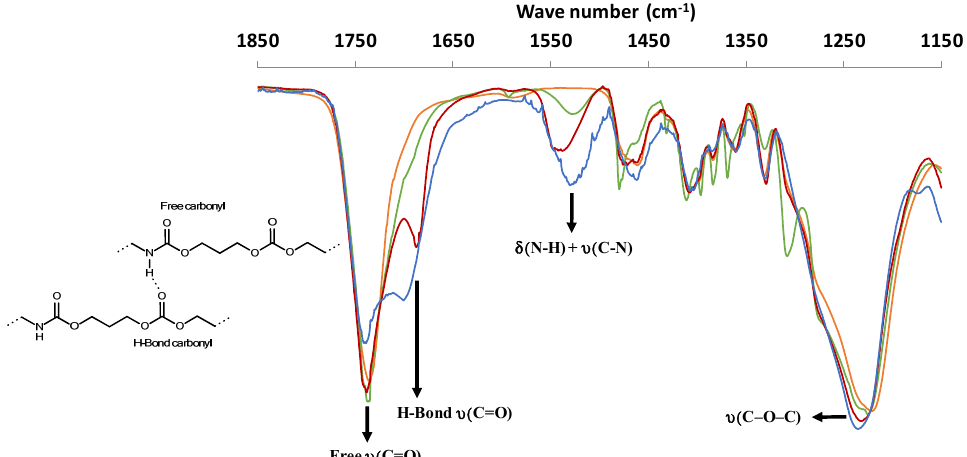
Figure 5. FTIR spectra of PTMC D - OH (orange), PTMC M - NH (green), PTMC D - NH (red), and PTMC T - NH (blue).